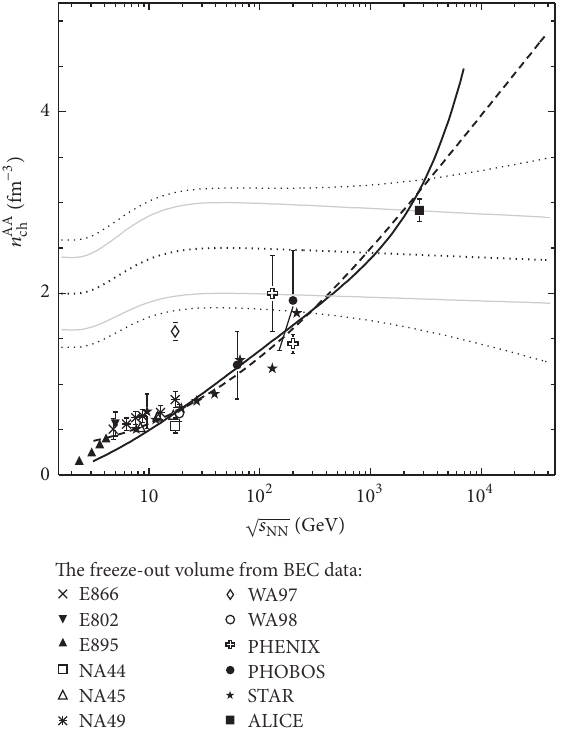
Figure 6: Energy dependence of estimations for charged particle density and for critical one in A + A collisions. Points are calculated [19] and the experimental with help of the hybrid function for 𝑁 ch estimations for 𝑉 and uncertainties for points are propagated from statistical errors of measurements and fits used. Solid line [17] and dashed line corresponds to the hybrid approximation of 𝑁 ch isforparametrizationoftotalchargedmultiplicityfrom[19].Critical charged particle density is shown by dotted line with its statistical uncertainty levels represented by thin dotted lines. The heavy grey calculatedbyvarying linescorrespondtothesystematic ±1 s.d.of 𝑛 ch of 𝜂 on ±0.05